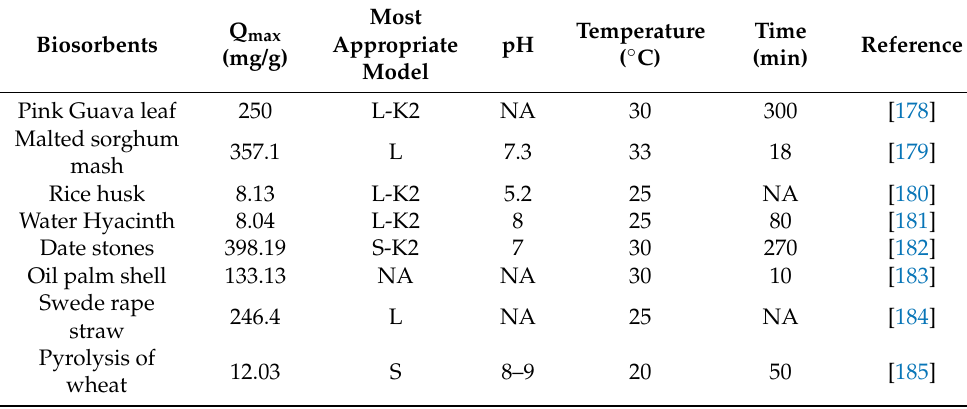
Figure 6. Schematic clarification of activated carbon derived from bio-waste and its potential uses. Table 4. Summary of bio-waste-derived adsorbent studies in